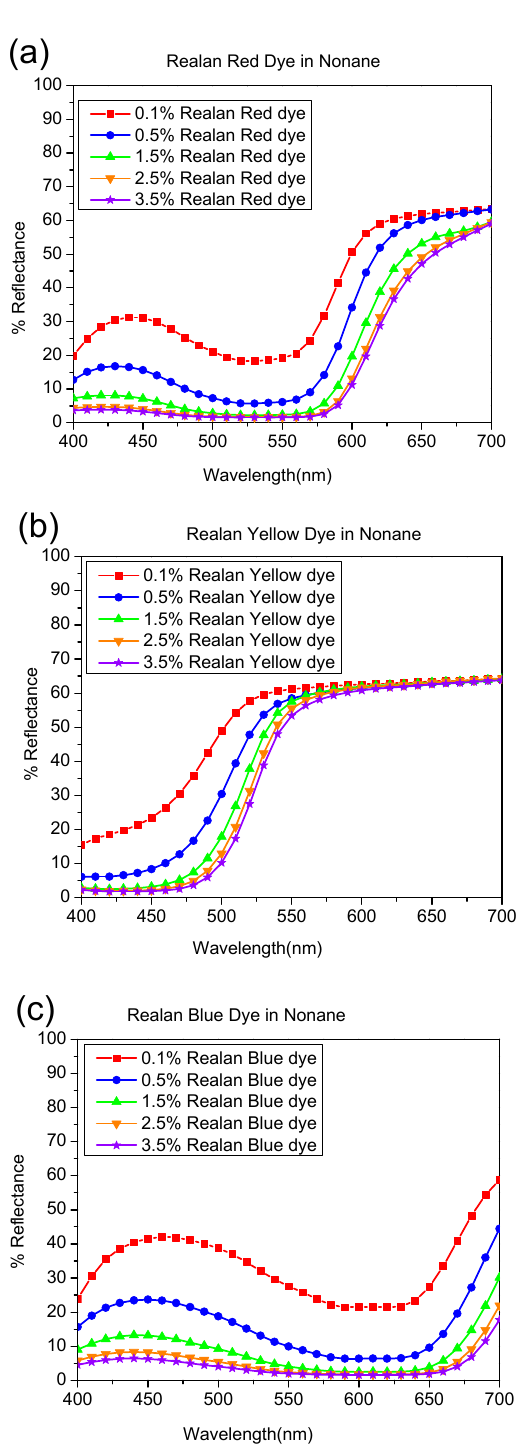
Figure 5. Percentage of reflectance value vs. wavelength (nm) of wool fibers dyed by ( a ) Realan Reactive Red, ( b ) Realan Reactive Yellow, and ( c ) Realan Reactive Blue in